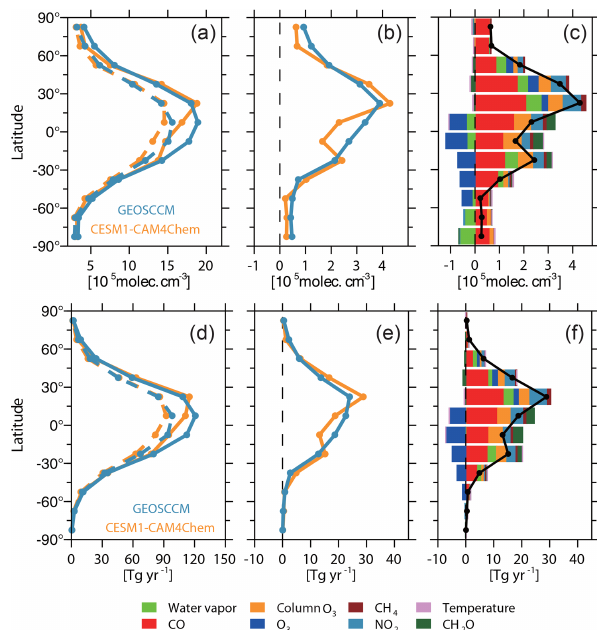
Figure 2. (a) Zonal-averaged [OH] trop-M of modeled (solid lines) and observation-based OH field (dashed lines) estimated from CESM1–CAM4Chem (yellow) and GEOSCCM (blue) simula- tions. (b) Difference of zonal-averaged [OH] trop-M between mod- eled and observation-based OH fields. (c) Difference between CESM1–CAM4Chem simulated and observation-based zonal- averaged [OH] trop-M (black line) and the contribution from each OH precursor (colored bars) to zonal-averaged difference. (d– f) Same as (a–c) but for the tropospheric CH 4 sink by reaction with OH.